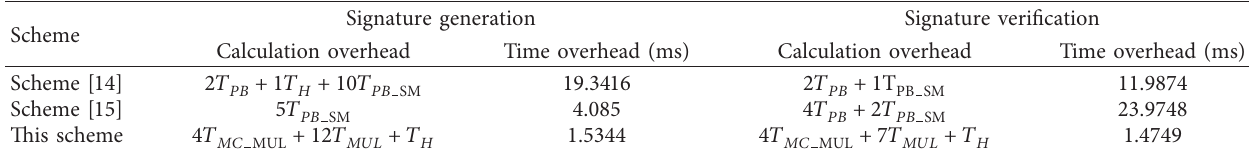
Figure 2: Comparison of average execution time of simulation Table 3: Signature generation and verification calculation overhead.